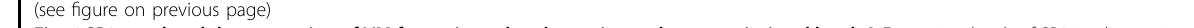
Fig. 6 SP2 regulated the expression of VM formation-related proteins at the transcriptional level. A Expression levels of SP2 in glioma tissues. Data are presented as the mean ± SD ( n = 9, each group). * P < 0.05 vs. NBTs group; # P < 0.05 vs. LGGTs group. B Expression levels of SP2 in glioma cells. Data are presented as the mean ± SD ( n = 3, each group). * P < 0.05 vs. HA group. C – E CCK-8 assay, transwell, and three-dimensional culture were applied to evaluate the proliferation, migration, invasion, and tube formation effect of SP2 on U87 and U251 cells. Representative images and corresponding statistical plots are shown. The scale bar represents 50 µm. F Protein levels of MMP2, MMP9, and VE-cadherin regulated by SP2 in U87 and U251 cells. Data are presented as the mean ± SD ( n = 3, each group). * P < 0.05, ** P < 0.01 vs. SP2( + )-NC group; # P < 0.05, ## P < 0.01 vs. SP2( − )-NC group. G – I Schematic representation of MMP2, MMP9, and VE-cadherin promoter region in 3000 bp upstream of the transcription start site (TSS) designated as + 1.Putative SP2 binding sites are